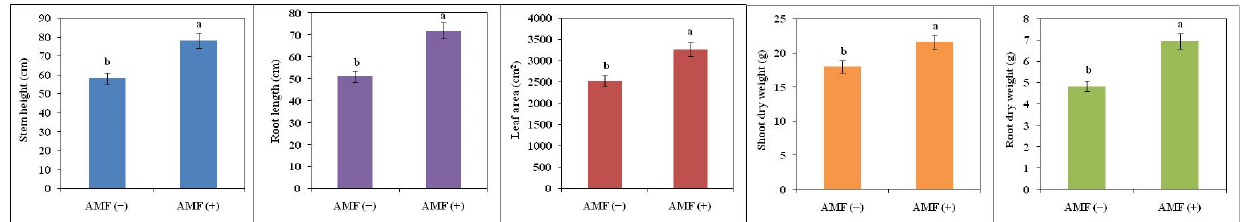
Figure 1. Plant height, root length, leaf area, shoot dry weight, and root dry weight of non-inoculated AMF ( − ) and inoculated plants AMF (+) of soybean. The vertical bar indicates ± SE for the mean. The means for each main treatment followed by the different letters are significantly different ( p ≤ 0.05).